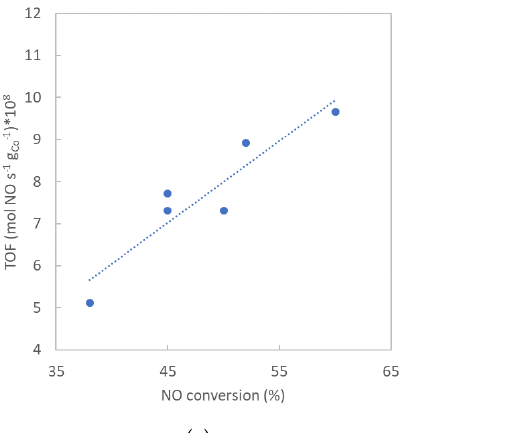
Figure 16. Dependence of TOF on: ( a ) NO conversion and ( b ) O 2 desorption.